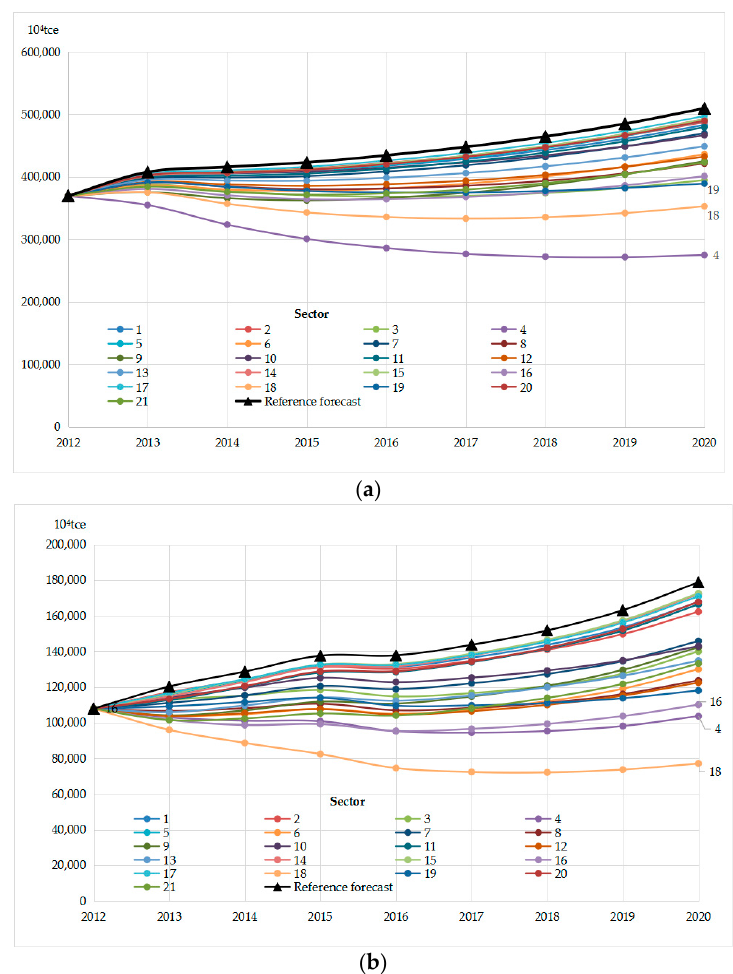
Figure 5. Energy consumption in the sensitivity analysis of improvement of fabrication level: ( a ) TPEC and ( b ) EECS.